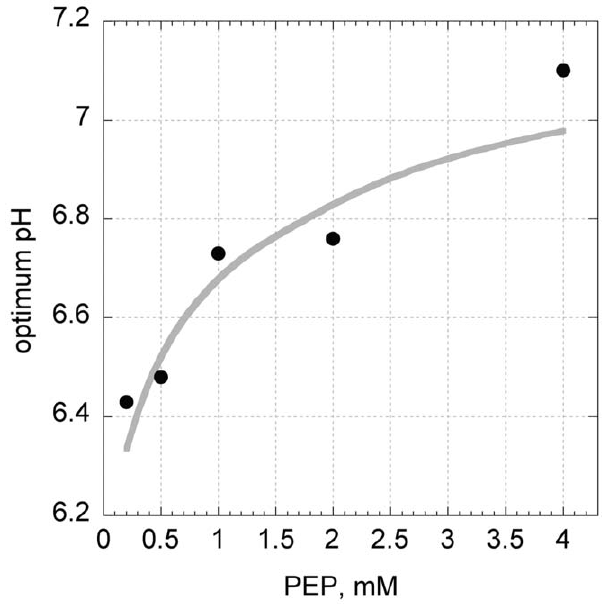
Figure 6. Optimum pH as a function of initial substrate concentration. Solid grey line shows the calculated optimum pH (Eq. 5) using a set of manually determined parameters. Solid dots show experimental results.